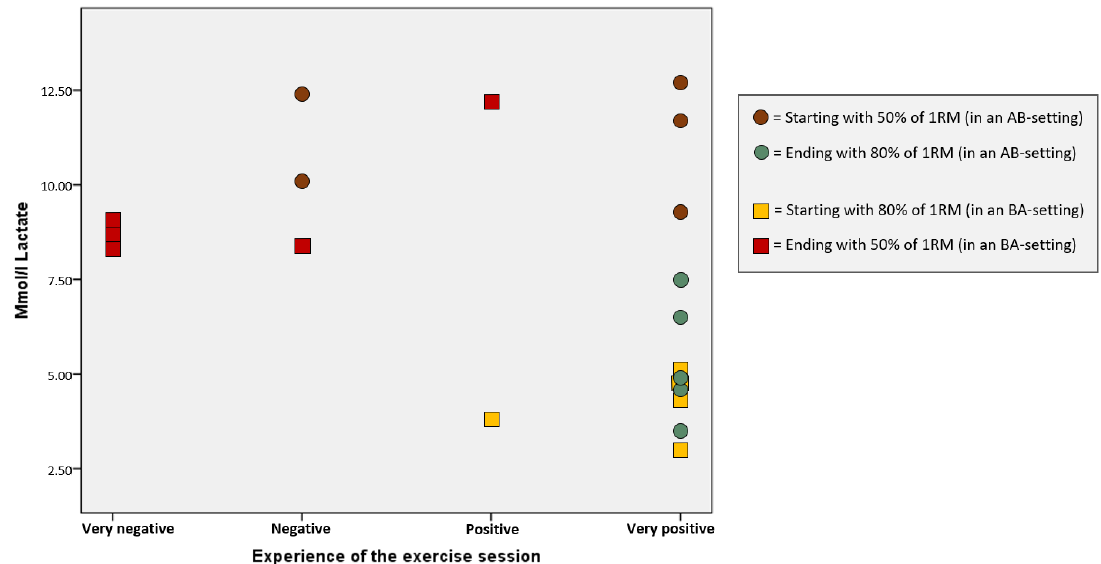
Figure 3. Scatter plot of lactate levels and participants’ experiences after the resistance exercise sessions.